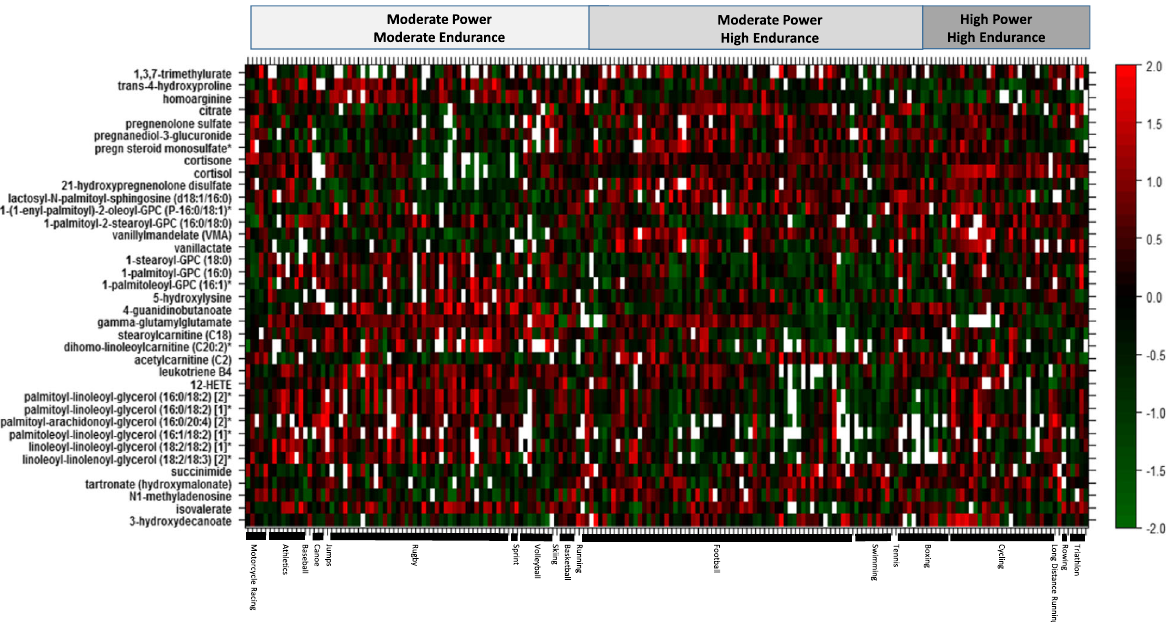
Fig. 6 Heatmap of metabolites significantly associated with high power from the linear model association analysis ( y -axis). Samples on x -axis were ordered by sports type and group. The color code denotes z -scaled values of metabolites after correction of